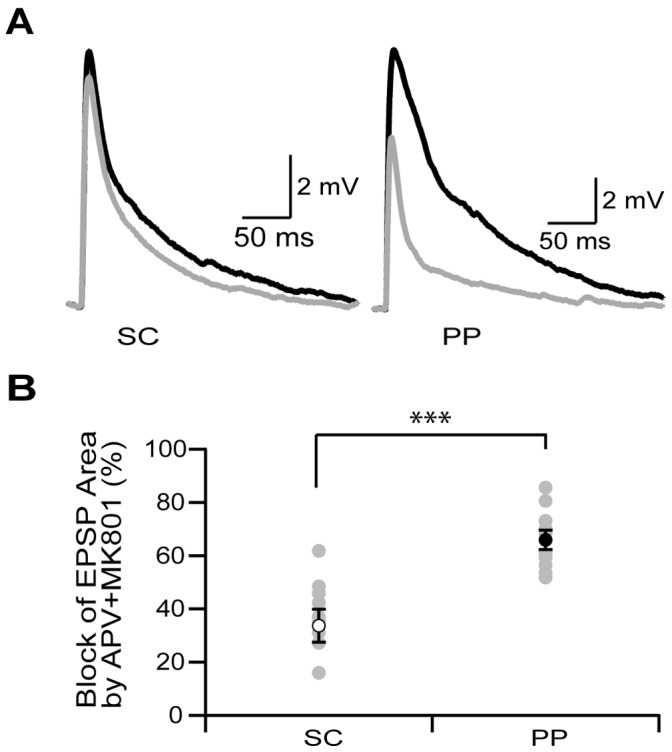
PP input to SLM recruits more NMDARs than SC input to SR.A. Evoked EPSPs in response to SC (left) or PP (right) stimulation in the absence (black) and presence (grey) of MK801 and APV. B. Percent of EPSP area blocked by MK801 and APV in response to SC (open symbol) or PP (closed symbol) stimulation (n = 10). ***denotes significance (p = 0.002, paired Wilcoxon). Average data are shown as mean ± SEM in black and individual patches are shown in grey.